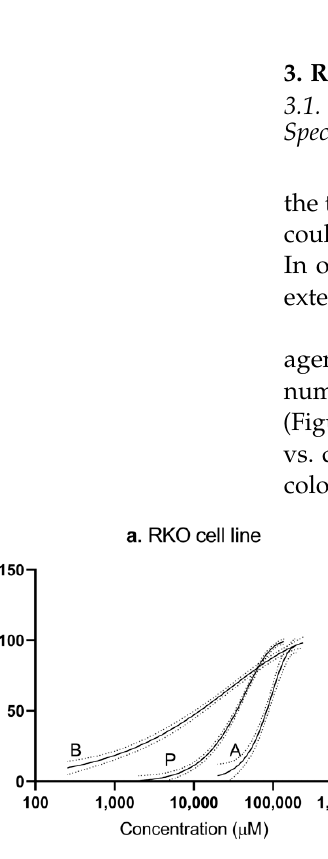
Figure 1. Regression models for the cytotoxic effects of all three mixture components in RKO ( a ), HCT- 15 ( b ), and NCM460 ( c ) cells. The solid lines represent the regression models for acetate, butyrate, and propionate obtained in the SRB assay, following 48 h incubations. The labels are as follows: A—acetate, B—butyrate, P—propionate (for values see Table 2). Black dashed lines represent the upper and lower 95% CI for the regression fit. Experimental data were obtained from a minimum of three independent experiments run in triplicate. Table 2. IC 50 and selectivity index determination. IC 50 values were estimated from the dose/growth response curves of SCFAs determined by SRB assay after 48 h of treatment in normal (NCM460) and CRC (HCT-15, RKO) cells. Values derived from at least three independent experiments. The selectivity index was calculated through the division of the IC 50 values obtained for each compound in the two CRC-derived cells, RKO and HCT-15, by the IC 50 value obtained for the same compound in normal colon-derived cells,